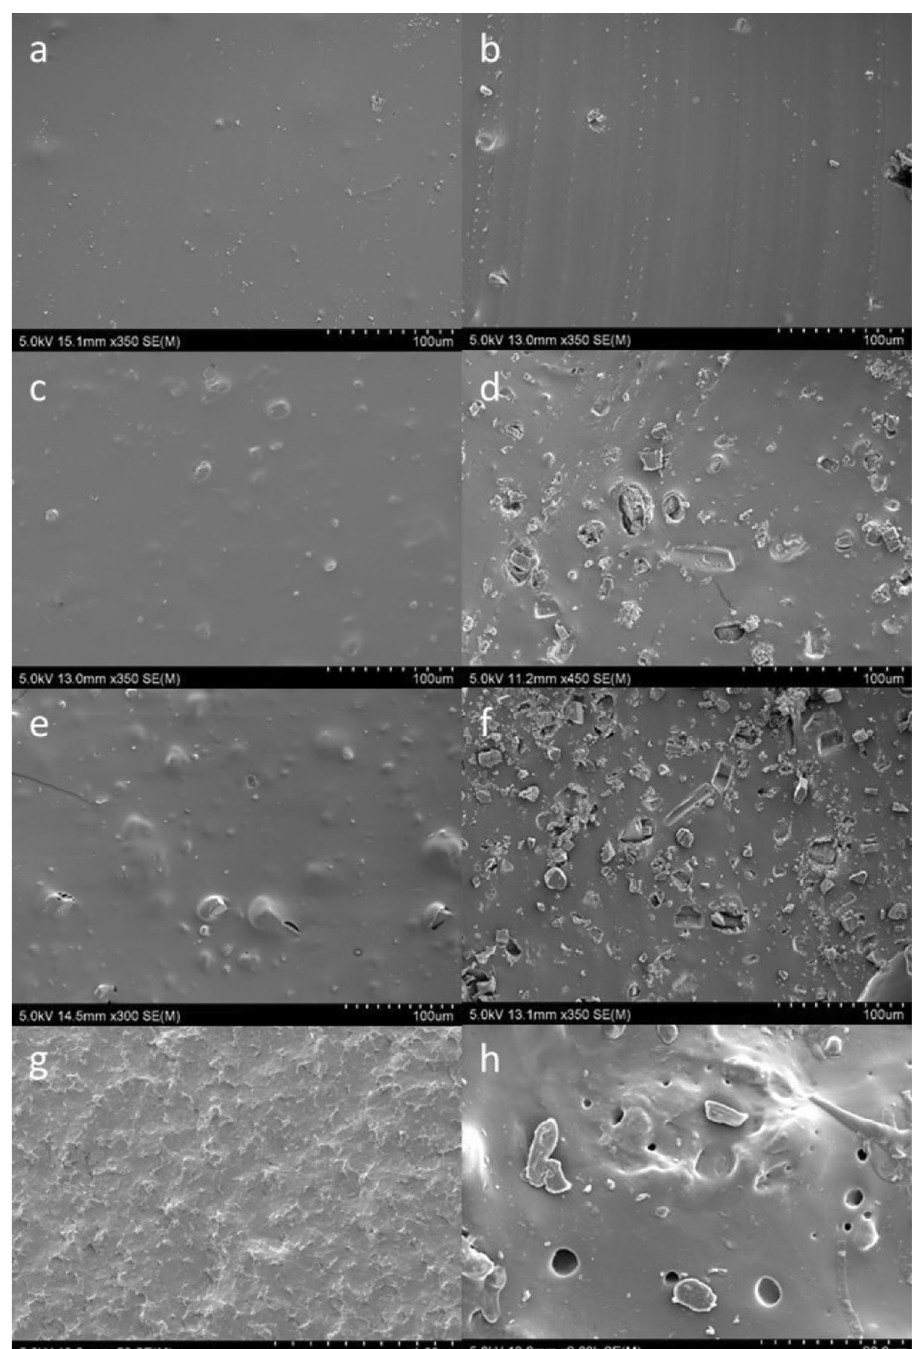
Figure 3. SEM micrographs of MED-4870 rings: ( a ) surface scan of MED-4870, 1% drug content sample; ( b ) cross-section scan of MED-4870, 1% drug content sample; ( c ) surface scan of MED-4870, 10% drug content sample; ( d ) cross-section scan of MED-4870, 10% drug content sample; ( e ) surface scan of MED-4870, 15% drug content sample; ( f ) cross-section scan of MED-4870, 15% drug content sample; ( g ) post submersion surface scan of MED-4870, 0.1% drug content sample after 4-month immersing in SVF solution; ( h ) post submersion cross-section scan of MED-4870, 0.1% drug content sample after 4-month immersing in SVF